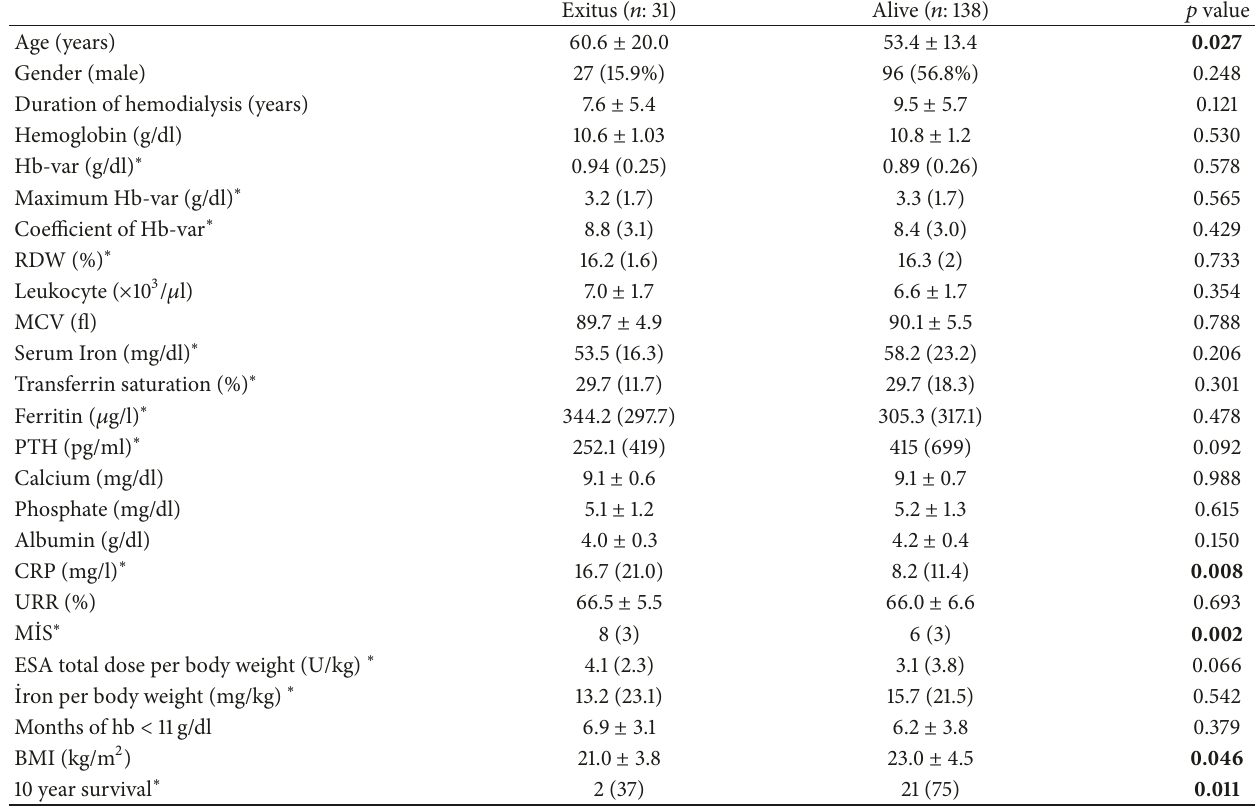
Table 3: Demographic characteristics, biochemical parameters, and medications of